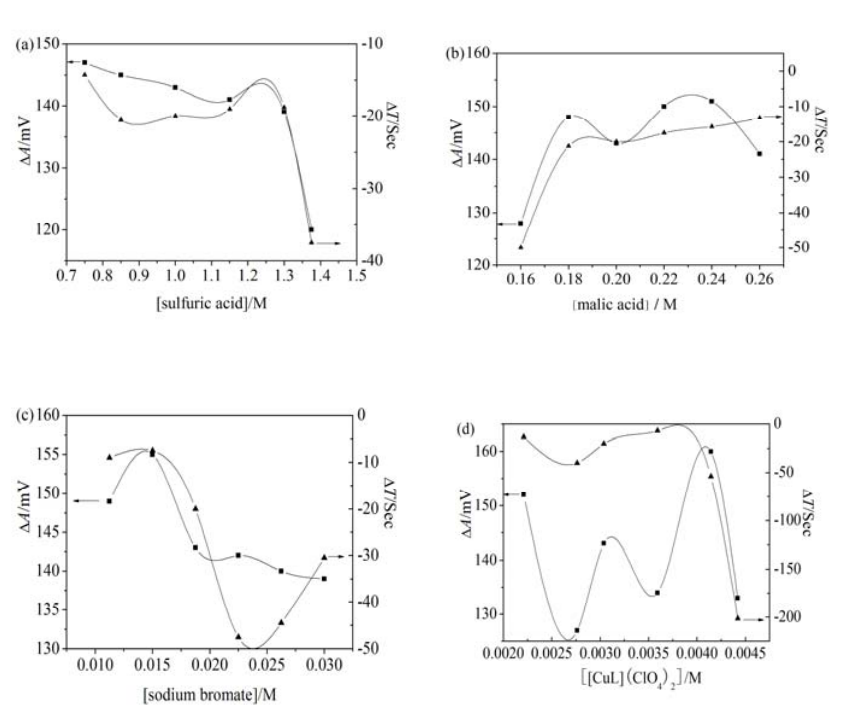
Figure 3 Influence of the concentration of (a) sulfuric acid; (b) malic acid; (c) sodium bromate; (d) [CuL](ClO ) ; on the oscillation system in the presence of 1.88×10 -5 M 4 2 paracetamol ( ■ refers to ∆ A and ▲ refers to ∆ T) Conditions: (a) [[CuL](ClO M, [NaBrO ] = 1.875×10 -2 M, [malic acid] = 0.20 M; (b) [[CuL](ClO 3 [NaBrO ] = 1.875×10 -2 M, [H SO ] = 1.0 M; (c) [[CuL](ClO 3 2 4 = 0.20 M, [H SO ] = 1.0 M; (d) [NaBrO ] = 1.875×10 -2 M, [malic acid] = 0.20 M, [H 2 4 3 = 1.0